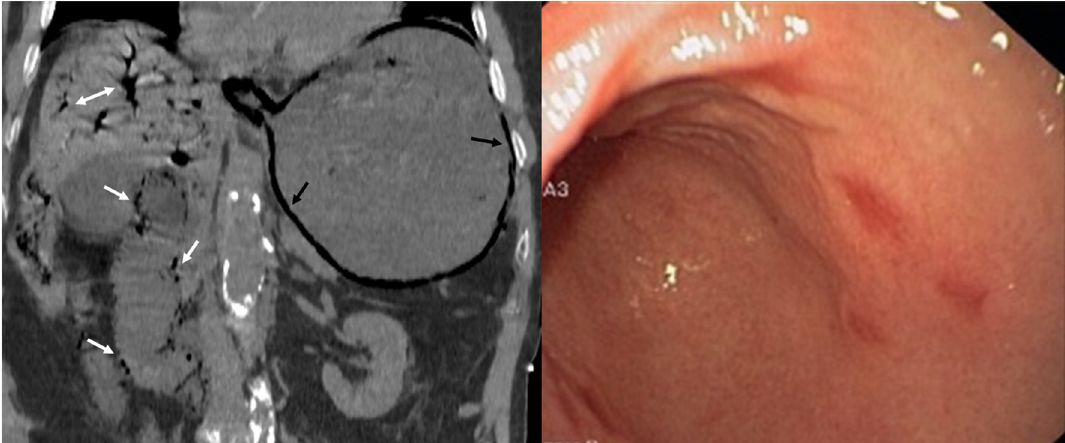
Fig. 23 A 58-year-old man with coffee ground vomitus, hypotension, and abdominal pain. Reformatted coronal unenhanced CT image shows a gastroparesis caused by extensive intramural bowel gas (pneumatosis